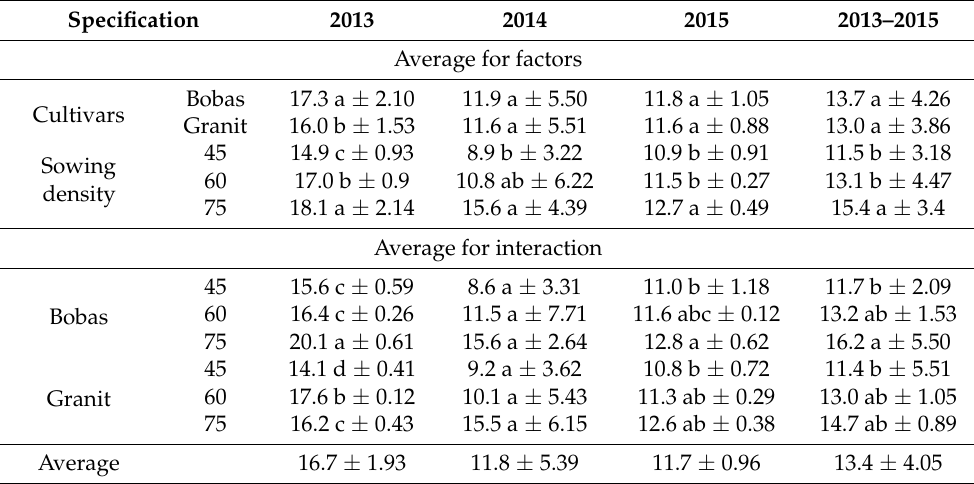
Table 6. Phosphorus accumulation in the faba bean seeds (kg ha − 1 ) as influenced by the examined factors during the study years 2013–2015.